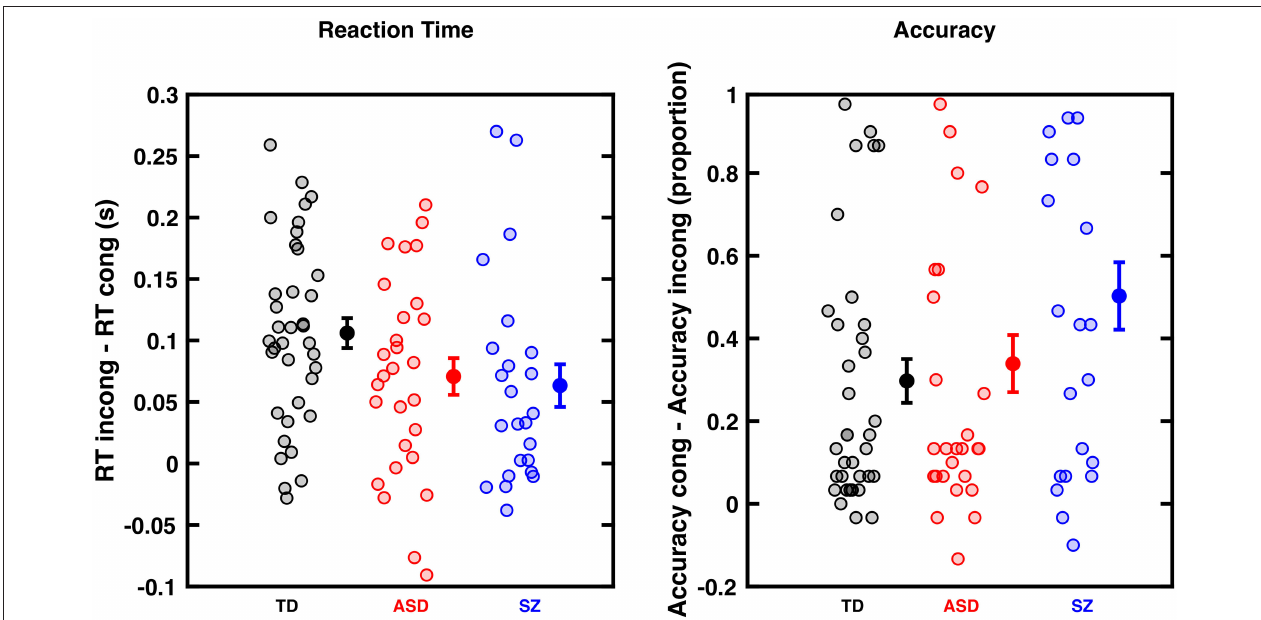
FIGURE 2 | Cross-Modal Congruency Effect (CCE) for RTs (left) and accuracy (right) in typically developing (TD) individuals, as well as Autism Spectrum Disorder (ASD), and Schizophrenic (SZ) patients. (A) CCE is the difference between tactile RTs when preceded by an incongruent or congruent visual cue (measured in seconds). Controls (black) individuals show numerically a larger cross-modal congruency effect than ASD (red) and SZ (blue) individuals, but this difference is not statistically significant. (B) Similar format but subtracting accuracy in incongruent trials from accuracy in congruent trials. Groups did not statistically differ. Dots are individual participants, error bars show the mean and ±